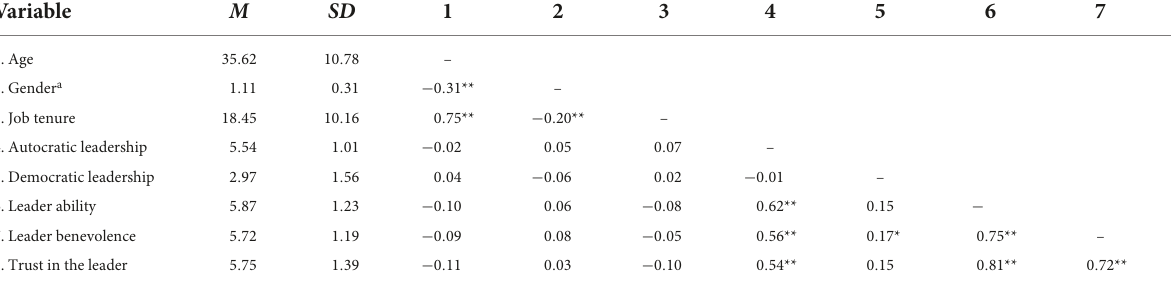
TABLE 4 Descriptive statistics and correlations for the action phase (Study 2). Variable